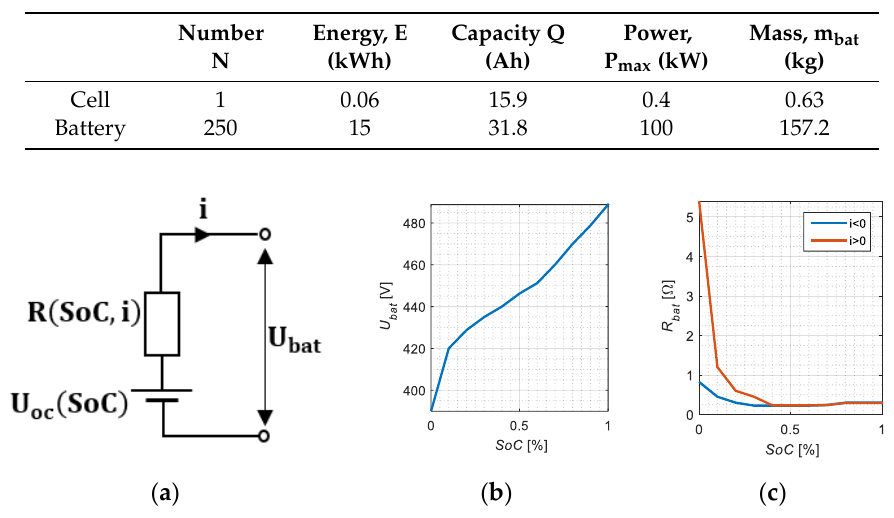
Table 4. Cell and battery parameters.